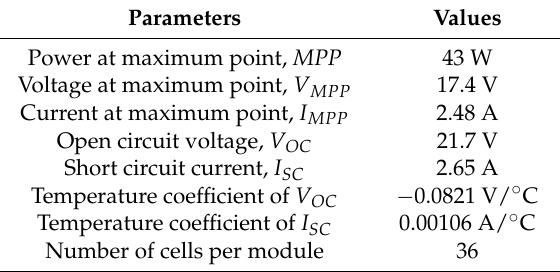
Table 1. Specifications of Solar KC40T at 1000 W/m 2 and 25 °C.